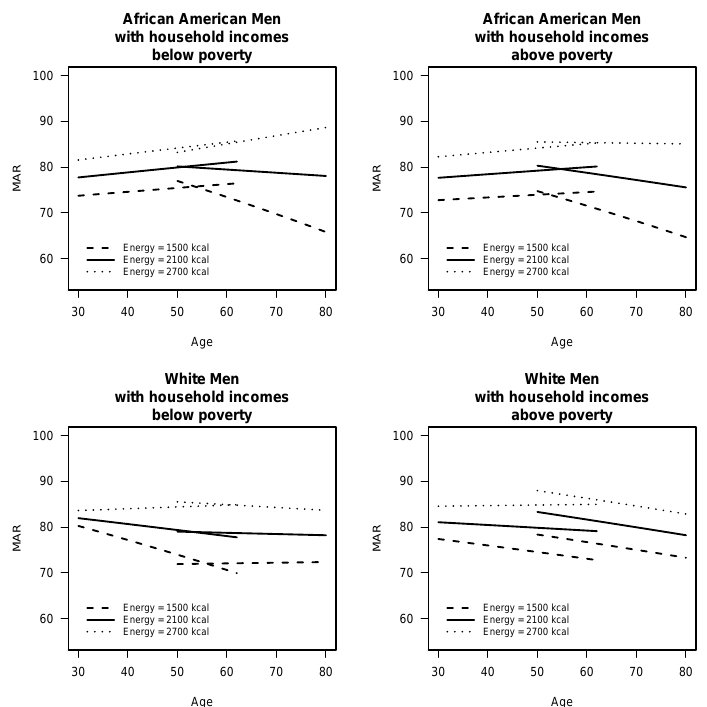
Figure 2. Mean Adequacy Ratio (MAR) scores across baseline and waves 3 and 4 of HANDLS study for men by initial age cohort ( < 50 or ≥ 50 years at baseline,) and by poverty ( < 125% or > 125% poverty threshold) for three levels of energy intake. HANDLS-Healthy Aging in Neighborhoods of Diversity across the Life Span.